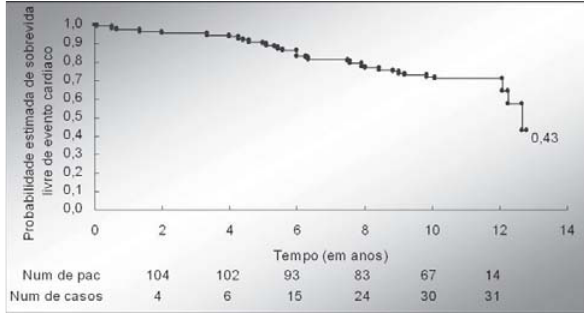
Fig. 2 – Probabilidade estimada de sobrevida livre de evento cardíaco